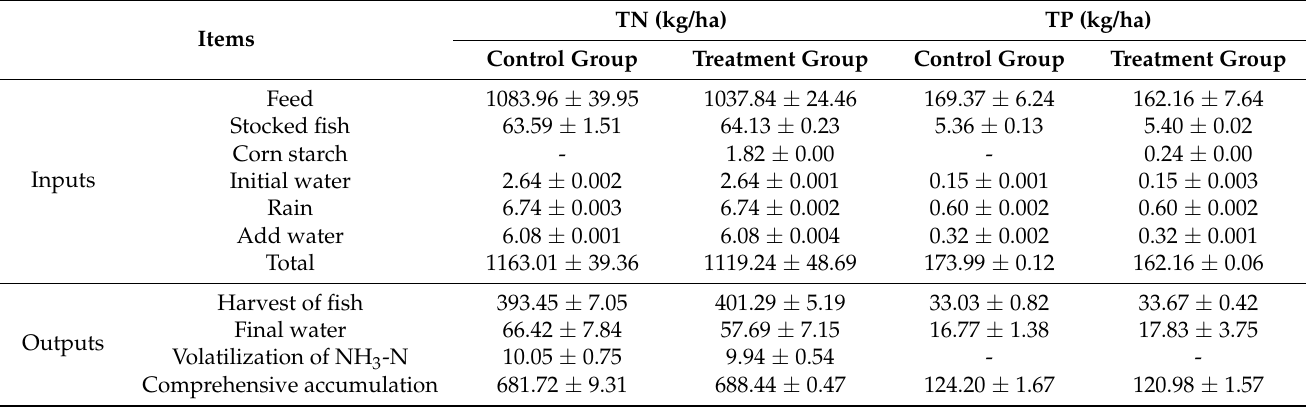
Table 3. TN and TP budget for different